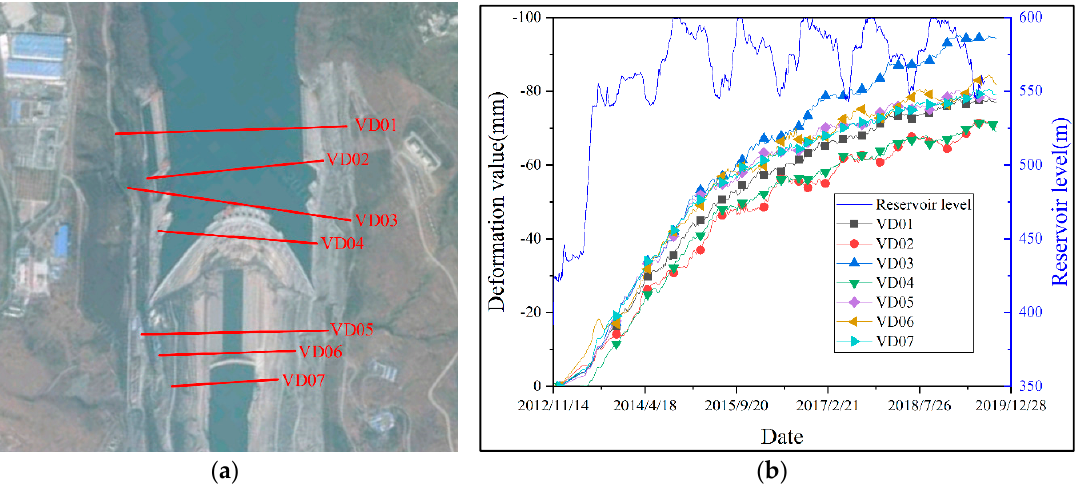
Figure 5. Basic information on the survey line monitor system: ( a ) spatial location of seven survey lines; ( b ) valley narrowing process since the initial impoundment.